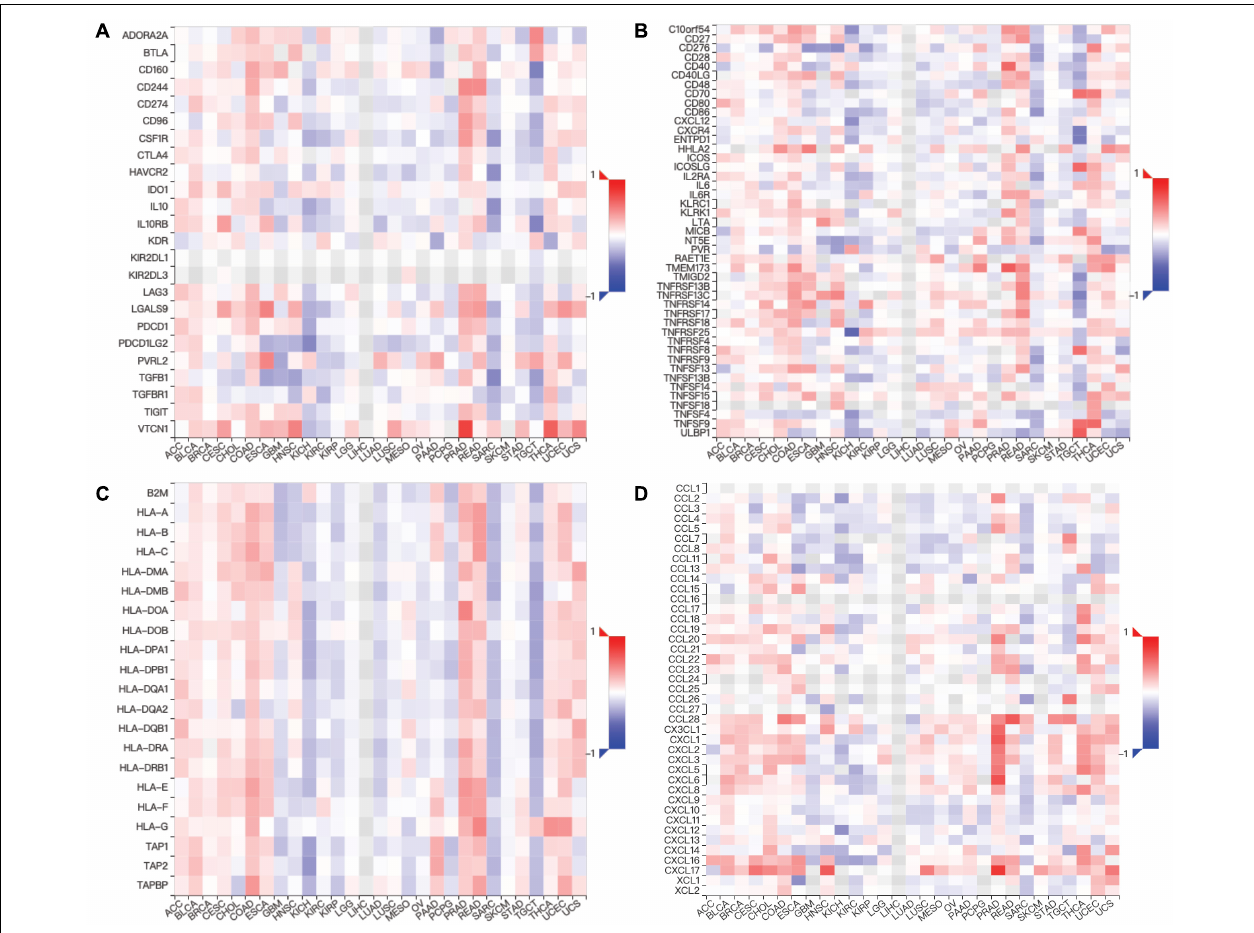
FIGURE 7 | Relations between expression of MUC4 and three kinds of immunomodulators and chemokines in TISIDB. Spearman correlations between expression of MUC4 and immunoinhibitors (A) , immunostimulators (B) , MHCs (C) , and chemokines (D) across human cancers.